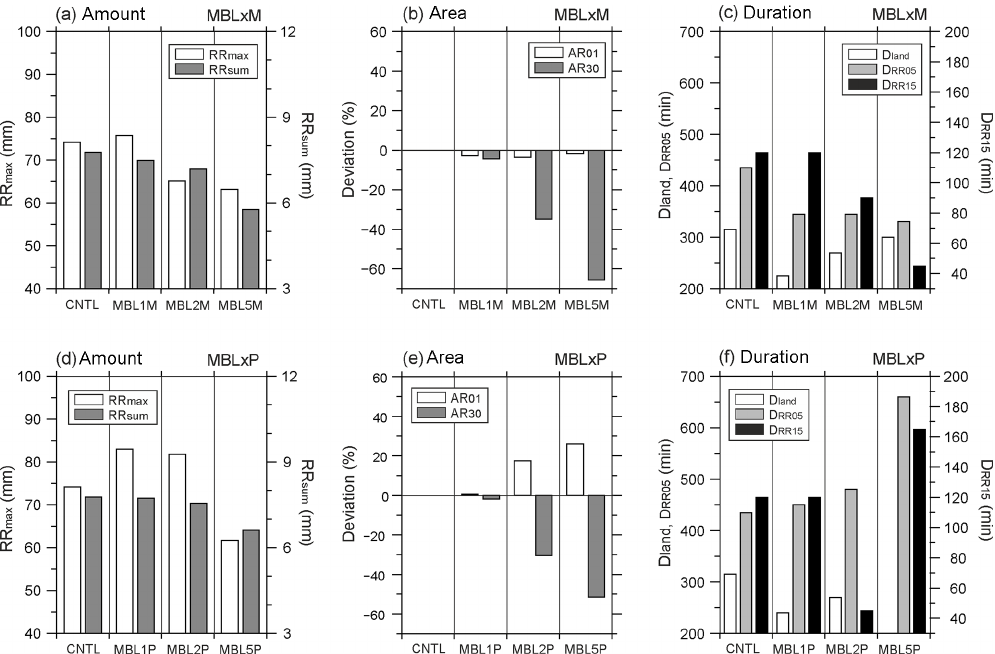
Figure 6. Results of CNTL, MBL × M (a–c) and MBL × P (d–f) experiments: panels (a) and (d) show the maximum 6h accumulated precipitation amount (RR max ) and the domain-averaged total sum of the 6h accumulated precipitation amount (RR sum ,mm) from 12:00UTC on 14 October 2012; panels (b) and (e) show the deviation of areas (km 2 ) of RR max ≥ 1mm (AR01) and RR max ≥ 30mm (AR30) in MBL to ones in CNTL; panels (c) and (f) show the duration of precipitation ( ≥ 5mm) over the land ( D land ), duration of precipitation ≥ 5mm per 15min ( D RR05 ), and duration of intense precipitation ≥ 15mm per 15min ( D RR15 ). The RR sum and duration of precipitation were calculated at a fixed area of latitude of 40.5–45 ◦ N and longitude of 3.5–9 ◦ E, where the sensitivity bubble passed though,